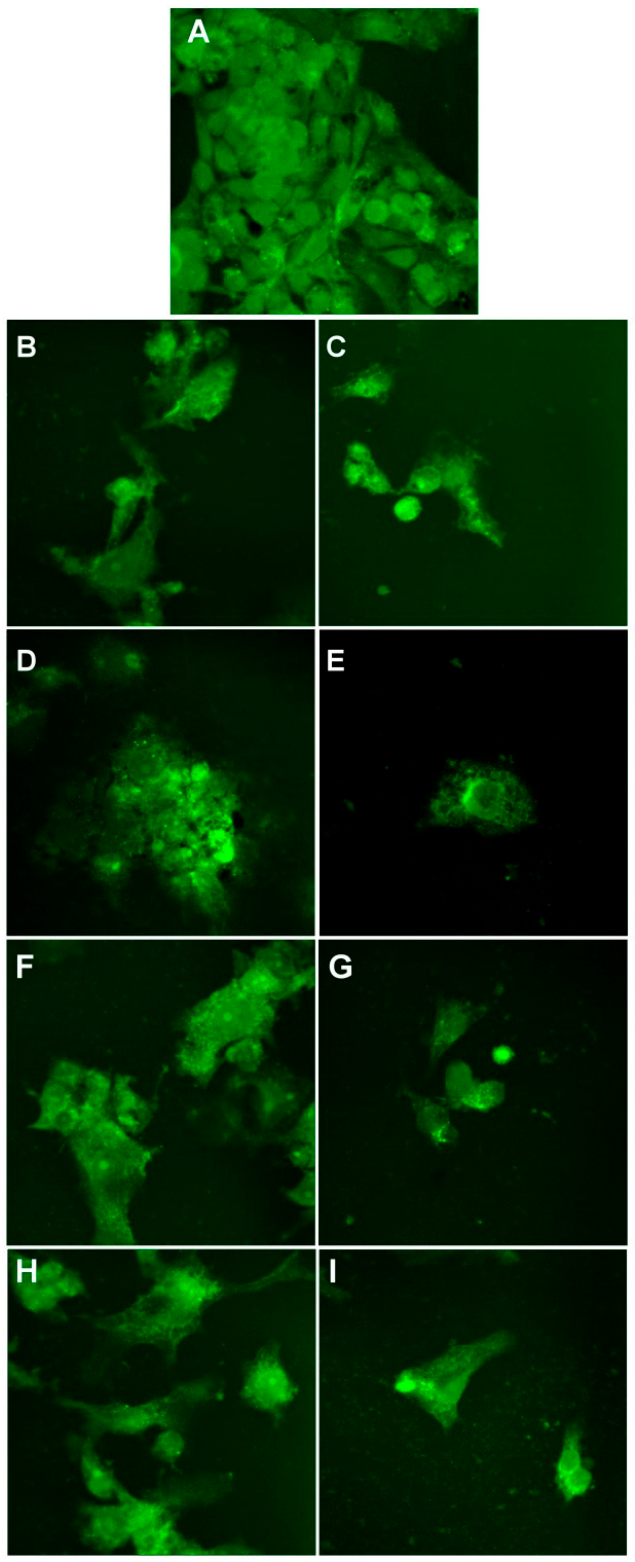
Figure 14. Morphology of control HT-29 cells ( A ) and cells after treatment with 6.4 µM and 51.1 µM of P3 ( B , C ), P4 ( D , E ), P5 ( F , G ), and P6 ( H , I ). Images are obtained with a 40× objective and in an epifluorescence mode.